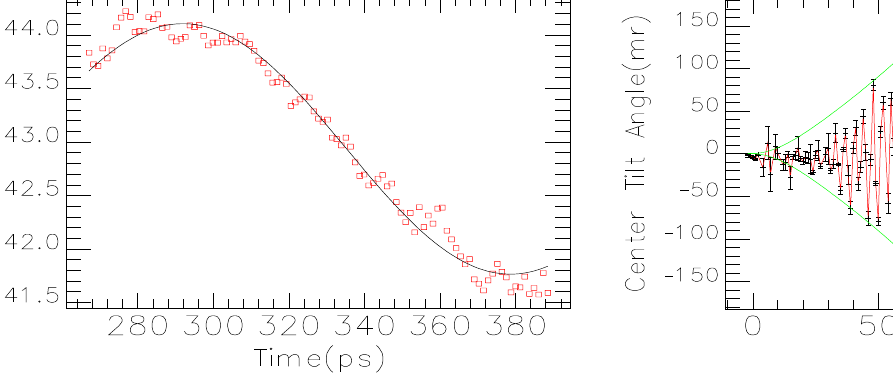
turn 72. The fit function is y (cid:3) y 23 : 35 ps (cid:2) 1 is calculated from Eq. (6), A 2 : 92 are obtained from fitting. Equation (6) gives A 1 : 15 mm